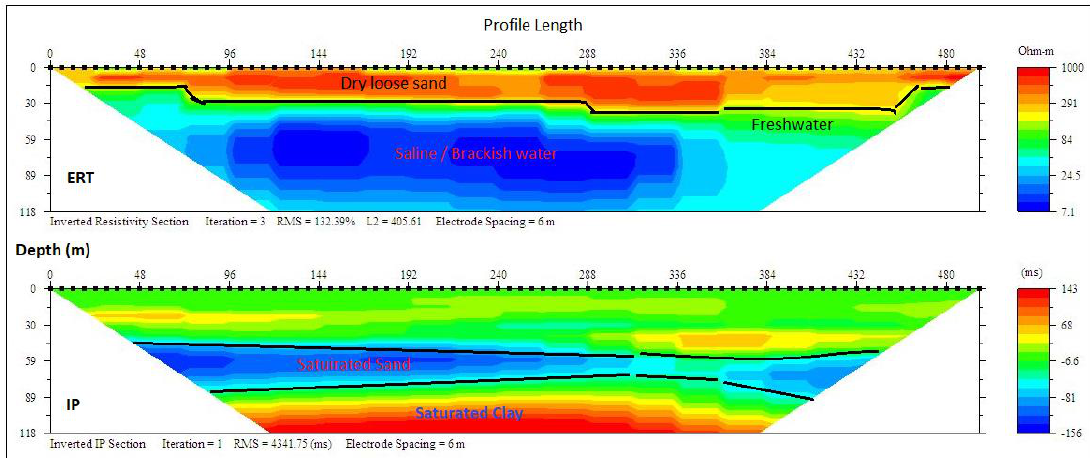
Figure 14. Inverted resistivity and IP cross-sections Okun-Ajjah (Profile section P10).